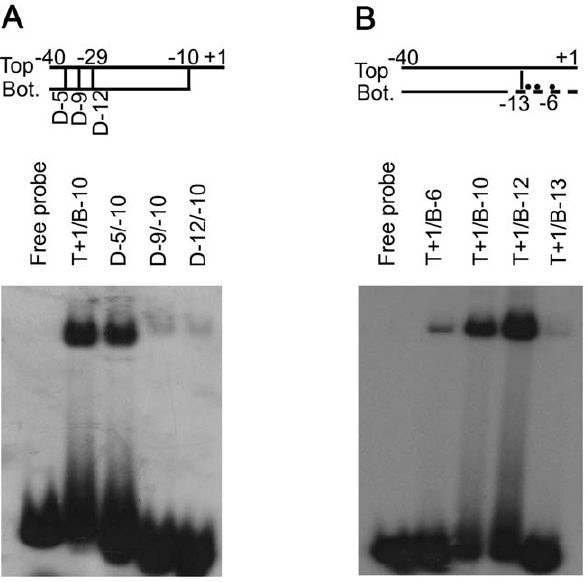
Figure 5. The effects of truncation in the 2 35 and 2 10 regions on the interaction between Tt-RpoE1 and promoter DNA. ( A ). EMSA results of truncation in the 2 35 region. The structure of parental probe is provided at the top, and vertical lines indicate truncated positions in the double-stranded region. Both the top and bottom strands were truncated from 2 40 to different positions indicated at the left of the fork-junction probe. The 3 9 terminus of top strand was kept at + 1, and the 5 9 terminus of the bottom strand was kept at 2 10. ( B ). EMSA results of truncations in the 2 10 region. The structure of parental probe is provided at the top. The T + 1 was the top strand for all the probes, and the bottom strand was truncated from B + 1 to different positions as indicated on the right of the bottom strand. The dots denote the terminal bases in the bottom strands in fork-junction probes. The protein concentration was 5 m M in all of the following experiments.